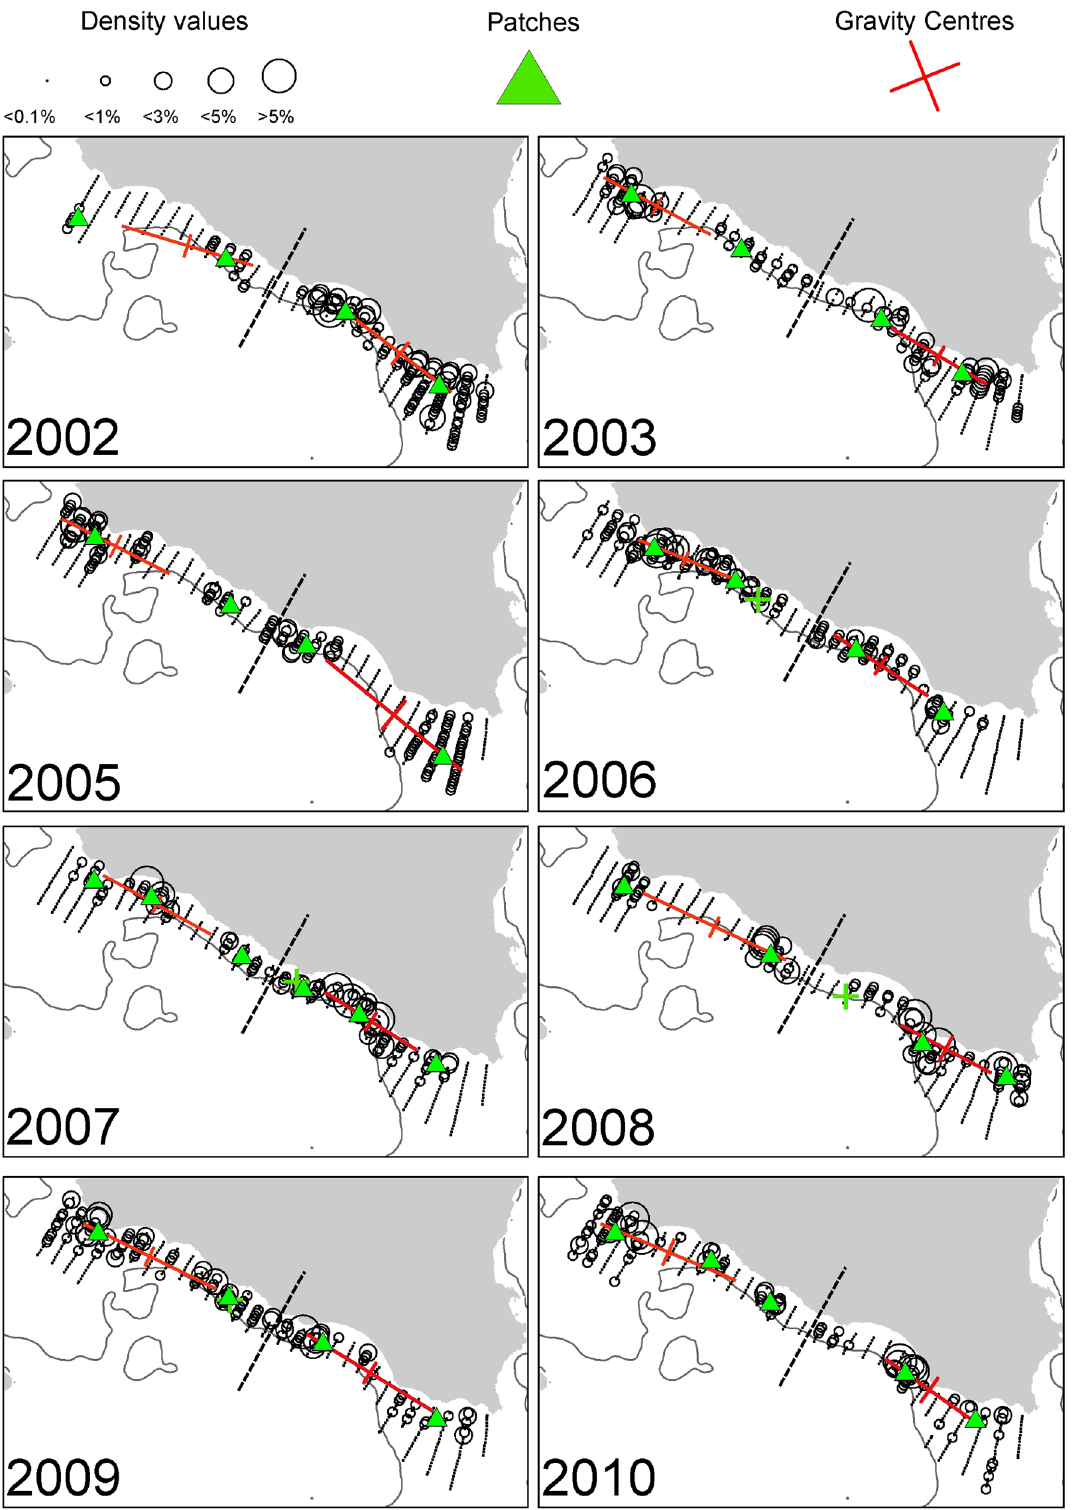
Fig 2. Annual maps of anchovy density distribution in the Strait of Sicily during summertime. The position of the centres of gravity and the main spatial patches (contributing > 10% to abundance) are shown. The 200 m isobath is indicated by a continuous line.